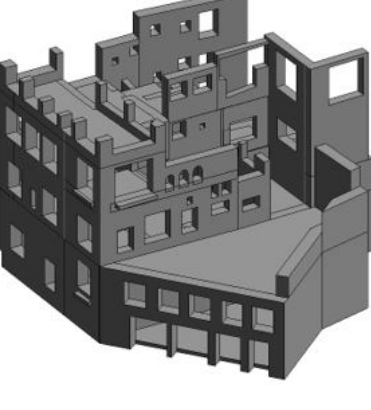
Figure 20. HBIM model for the external and internal walls.